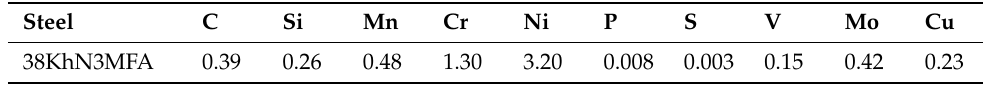
Table 1. Chemical composition of steels (wt., %, Fe—balance).